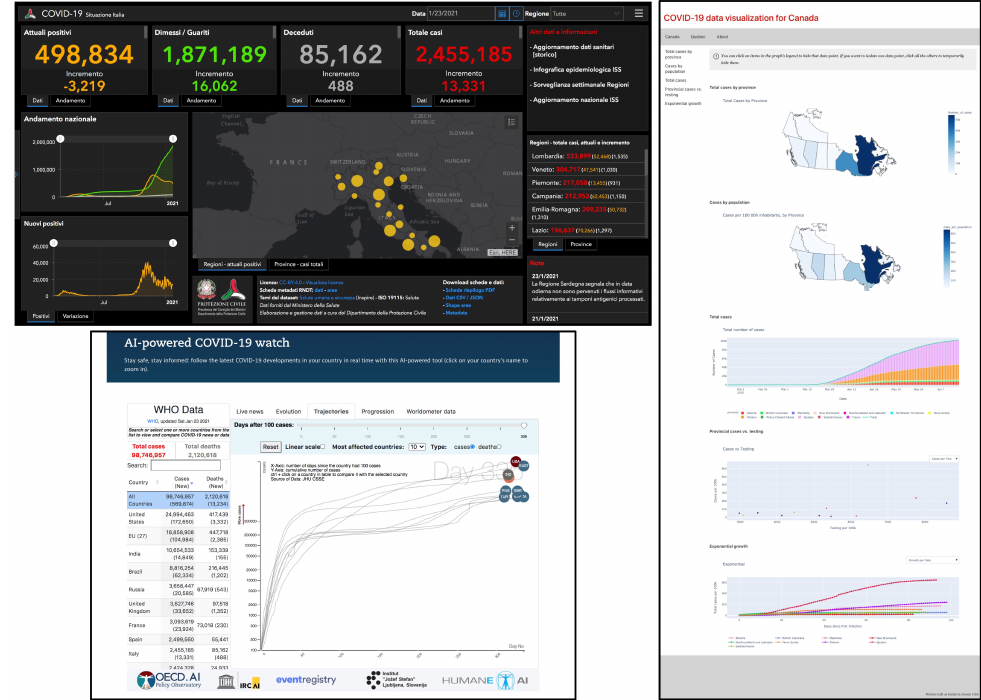
Figure 3. E xamples of three categories of Geo-OEDV tools. Top left: dashboard of the Italian Civil Protection; available online at https://opendatadpc.maps.arcgis.com/apps/opsdashboard/index. html#/b0c68bce2cce478eaac82fe38d4138b1); screenshot date: 23 January 2021. Bottom left: explorer of the OECD.AI; available online at https://www.oecd.ai/p/covid-19; screenshot date: 23 January 2021. Right: infographic of private citizens: Nicolas Bent and Jeremy Cobb; available online at https://canadian-covid-visualizations.netlify.app/; screenshot date: 23 January